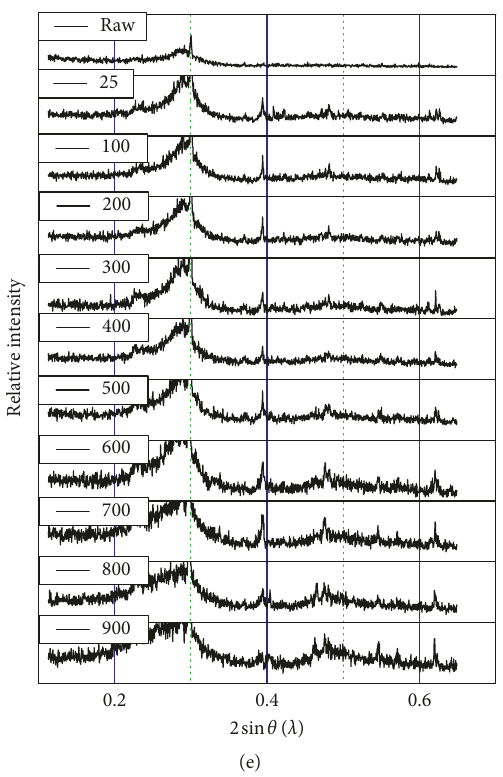
Figure 7: In situ XRD pattern of five coal samples at different temperatures: (a) SX; (b) KL; (c) HN; (d) HB; (e) GZ.